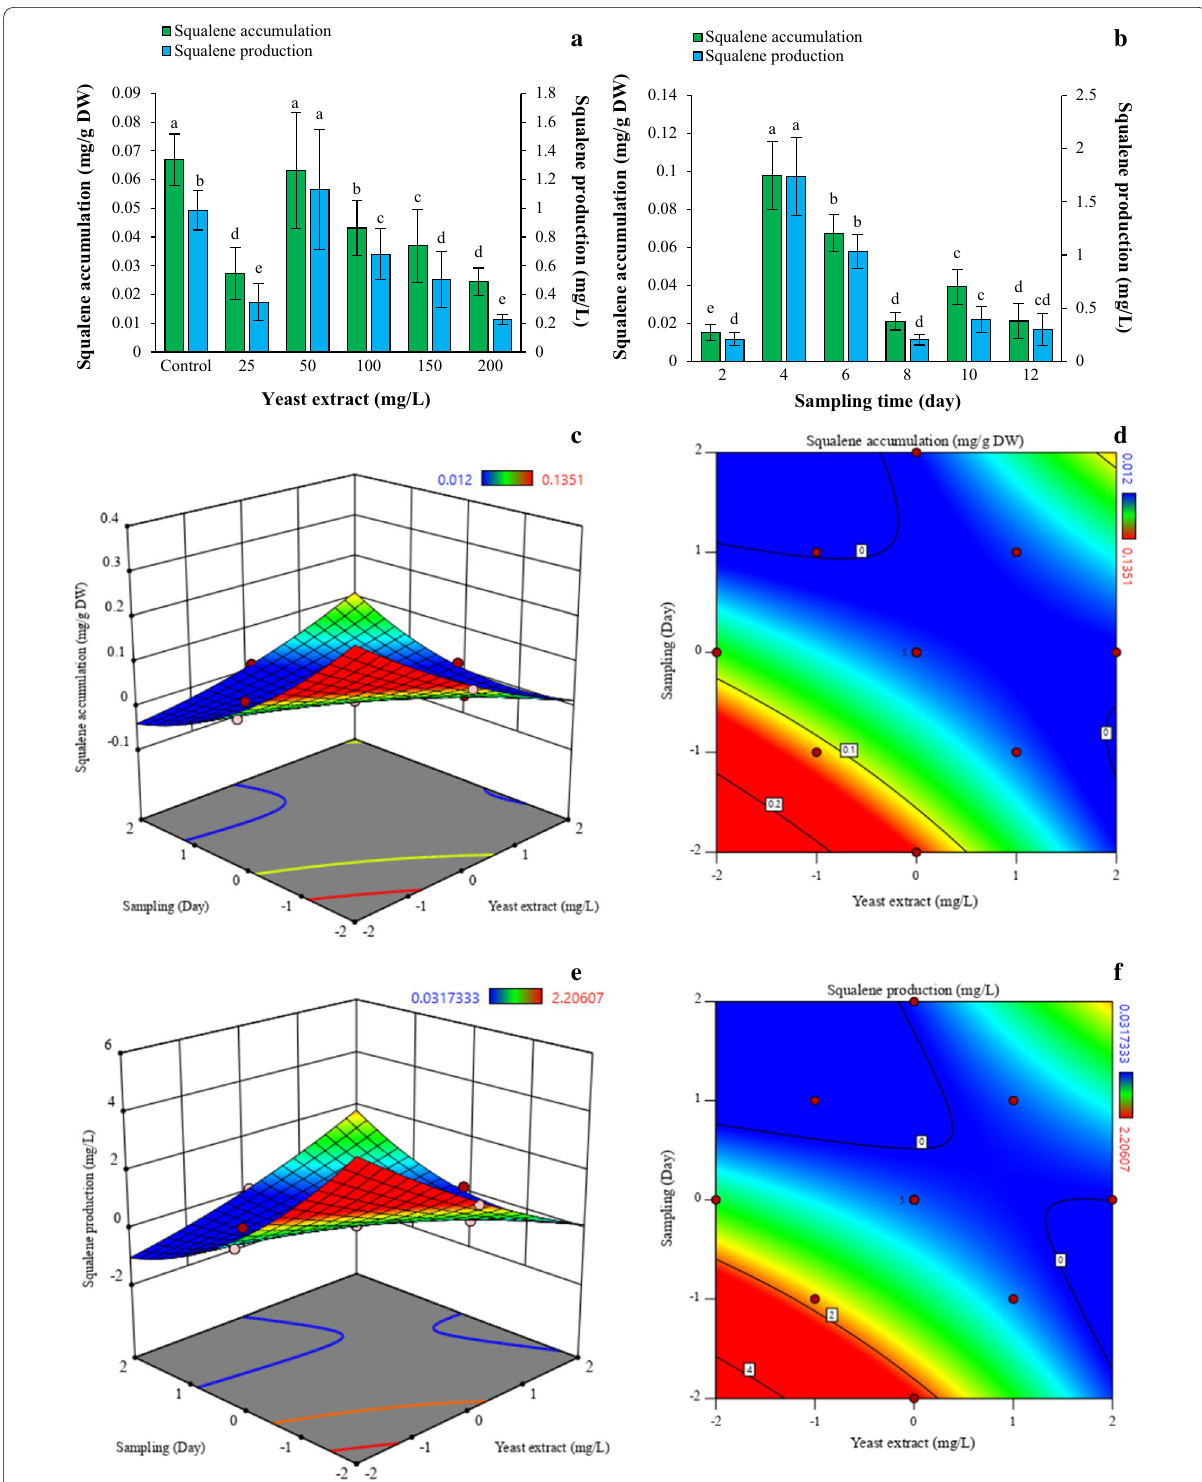
Fig. 4 The effect of different concentrations of yeast extract and sampling times ( a , b ) and response surface and contour plots for squalene accumulation ( c , d ) and squalene production ( e , f